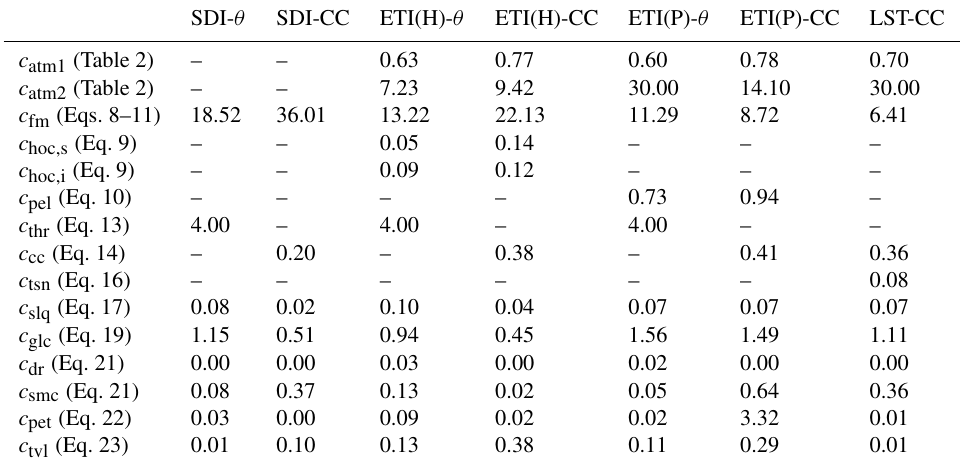
Table B2. All fitting parameters calibrated for Wolverine used in each of the models presented in Table